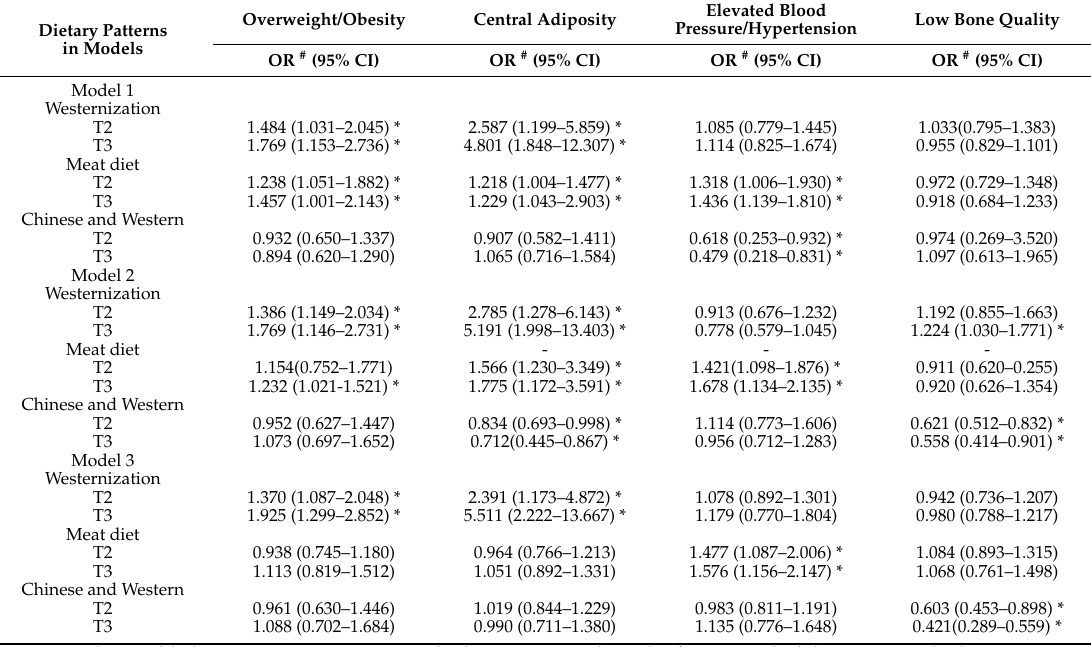
Table 5. Odds ratios (95% confidence intervals) for components of adverse outcome across tertiles of major dietary pattern